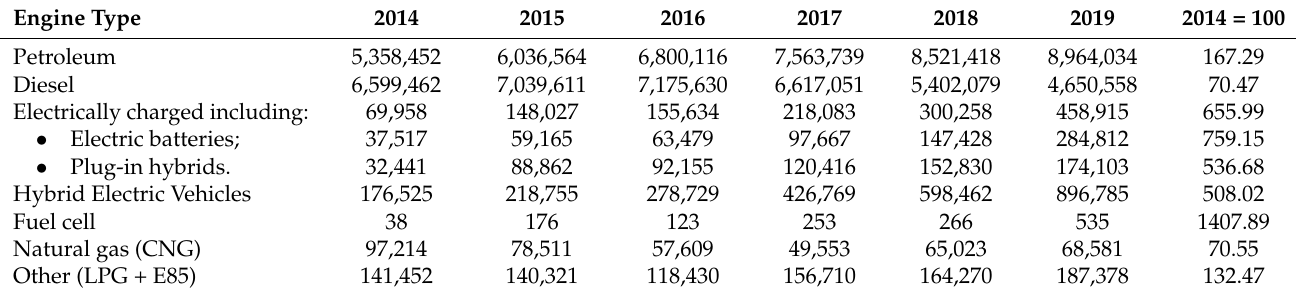
Table 3. New cars registered in the EU depending on the type of fuel in the years 2013–2019.